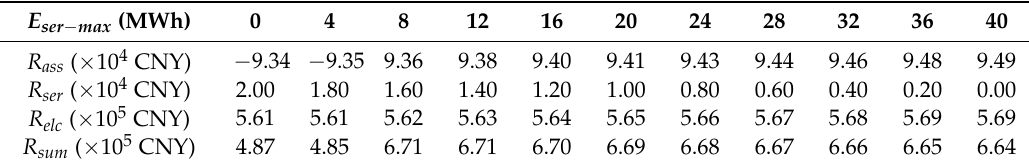
Table 4. The revenue of VPP of typical scenario 2.